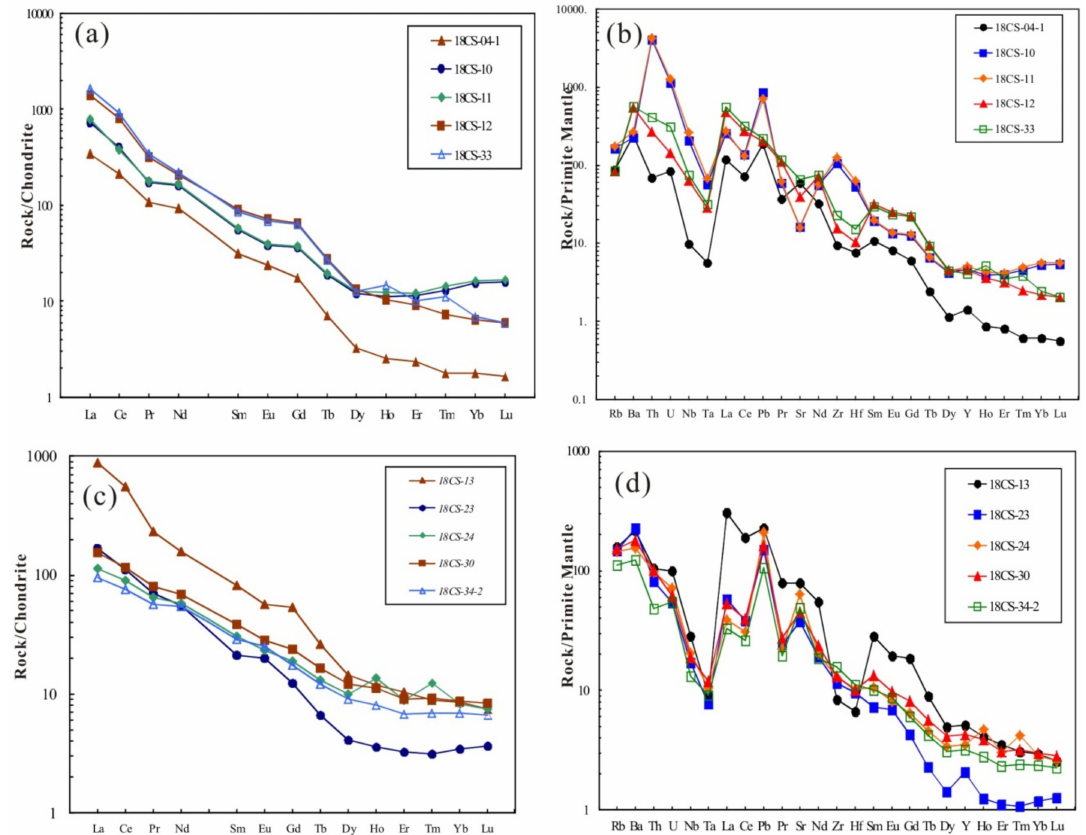
Figure 5. Chondrite-normalized REE patterns and primitive mantle (PM) normalized trace element spider diagram for quartz syenites ( a , b ) and alkali granites ( c , d ) from the Chishan alkalic complex (chondrite and PM values are from